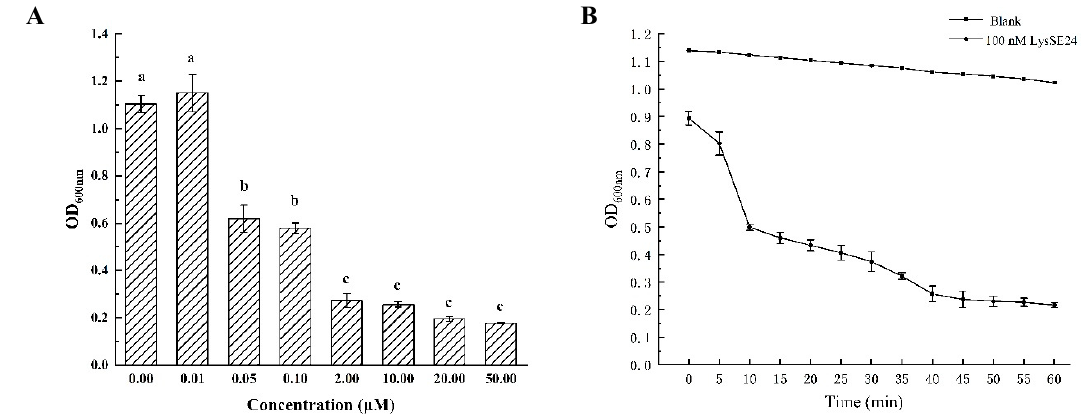
Figure 3. The e ff ect of endolysin LysSE24 on the OD 600nm values of host strain S. Enteritidis ATCC 13076. ( A ) The e ff ect of di ff erent concentrations of LysSE24 on the OD 600nm value of S. Enteritidis ATCC 13076. The di ff erent letters (a, b, c, and d) in the figure indicate significant di ff erences ( p < 0.05). ( B ) The OD 600nm values of S. Enteritidis ATCC 13076 was measured every 5 min for a total of 60 min by using 100 nM LysSE24.